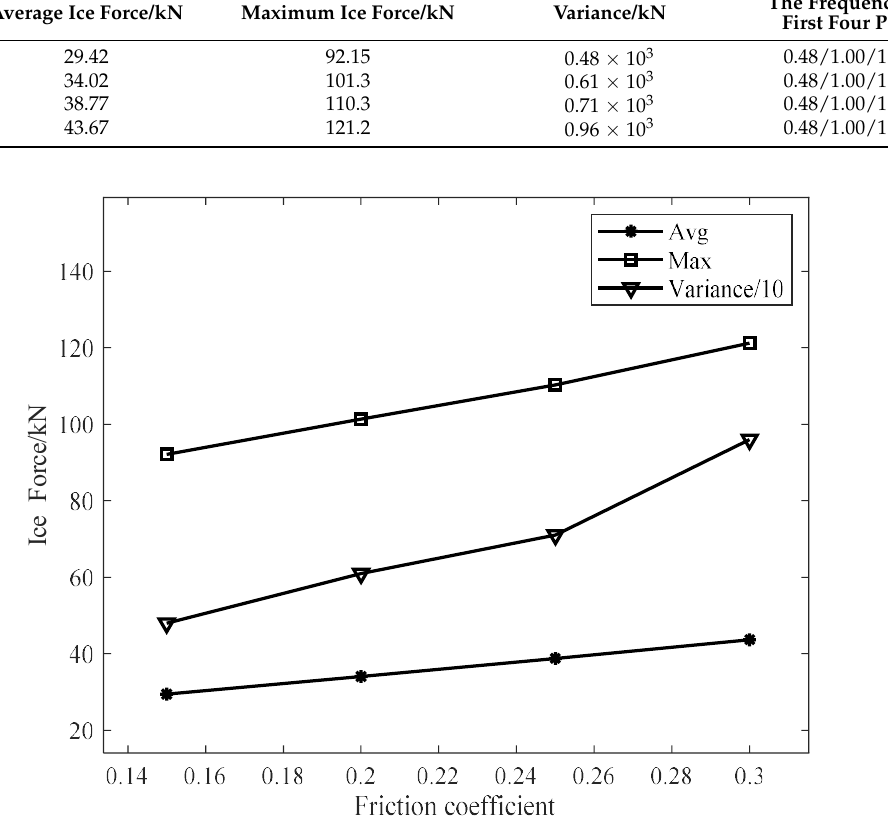
Figure 27. Change trend of variance and ice force with friction coefficient (µ).